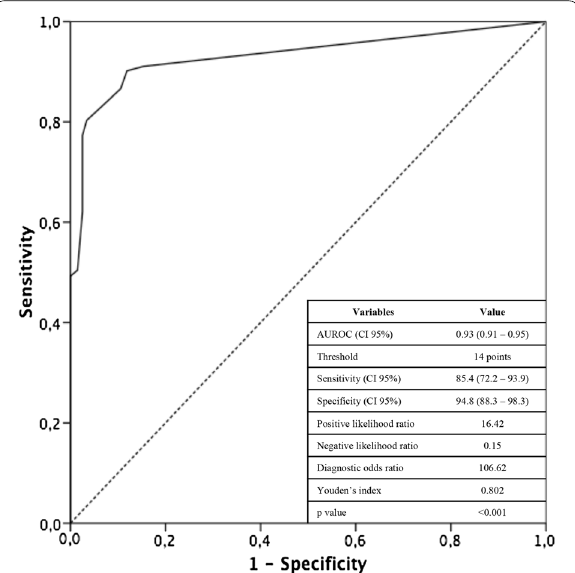
Fig. 3 ROC curve showing the sensitivity and specificity of the PALM score including the four markers (PCT, ASAT, lactate, and myoglobin) for predicting the diagnosis of bowel ischemia. The AUROCC [95% confidence interval] was 0.93 [0.91–0.95]; p <